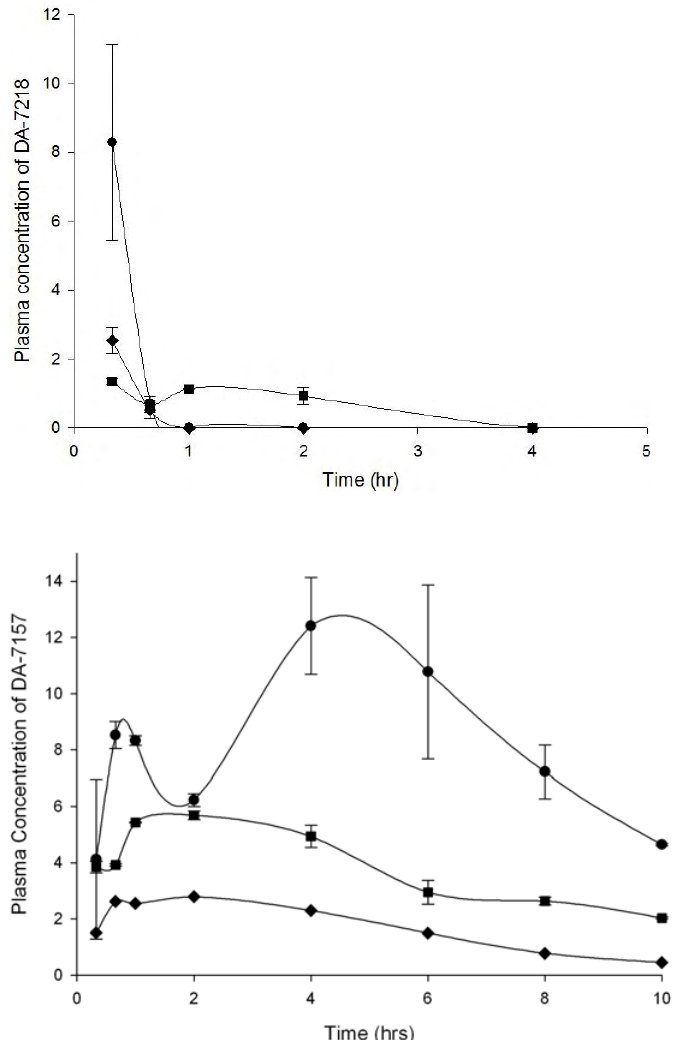
Figure 1.- Mean plasma levels of DA-7218 and DA-7157 in BALB/c mice at dose of